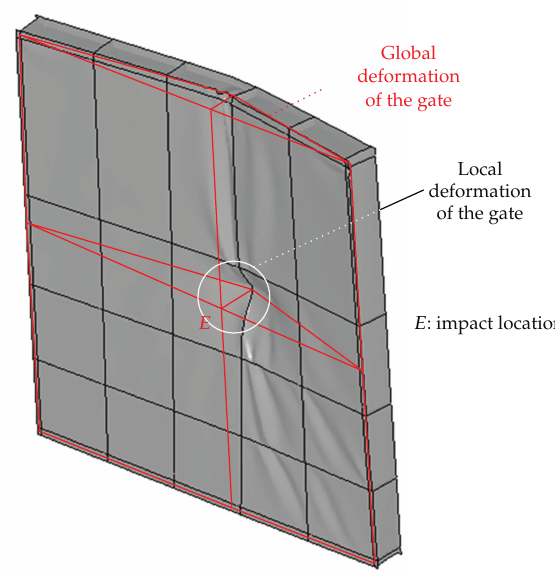
Figure 10: Illustration of global and local